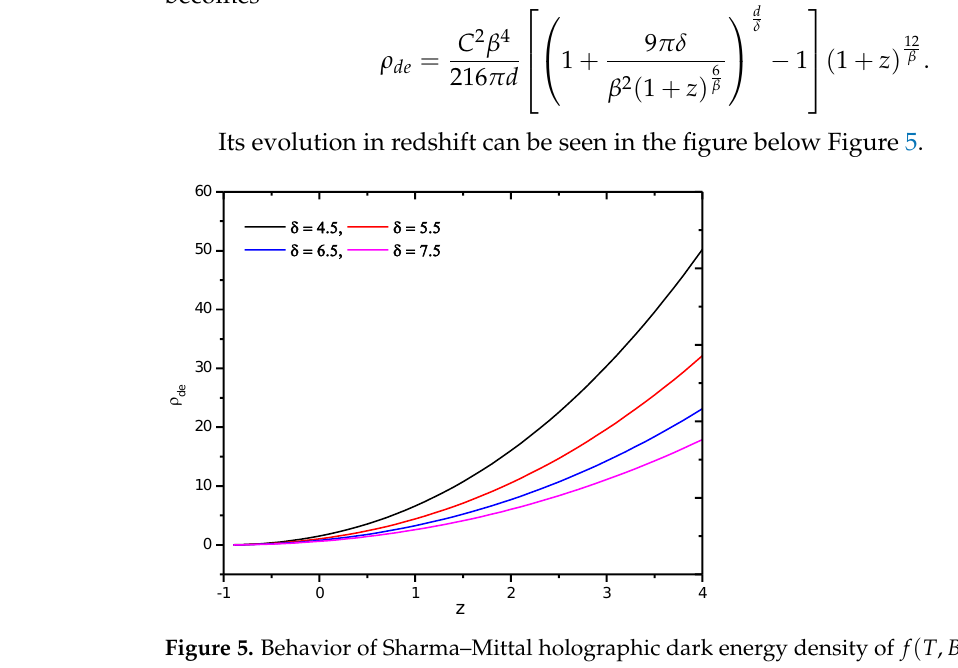
Figure 5. Behavior of Sharma–Mittal holographic dark energy density of f ( T , B ) gravity model in Hubble’s horizon cutoff versus redshift for the appropriate choice of constants d = 1.82, C 2 = 0.1, β = 6, m = 14, m 1 = 0.001, n = 10 and n 1 =